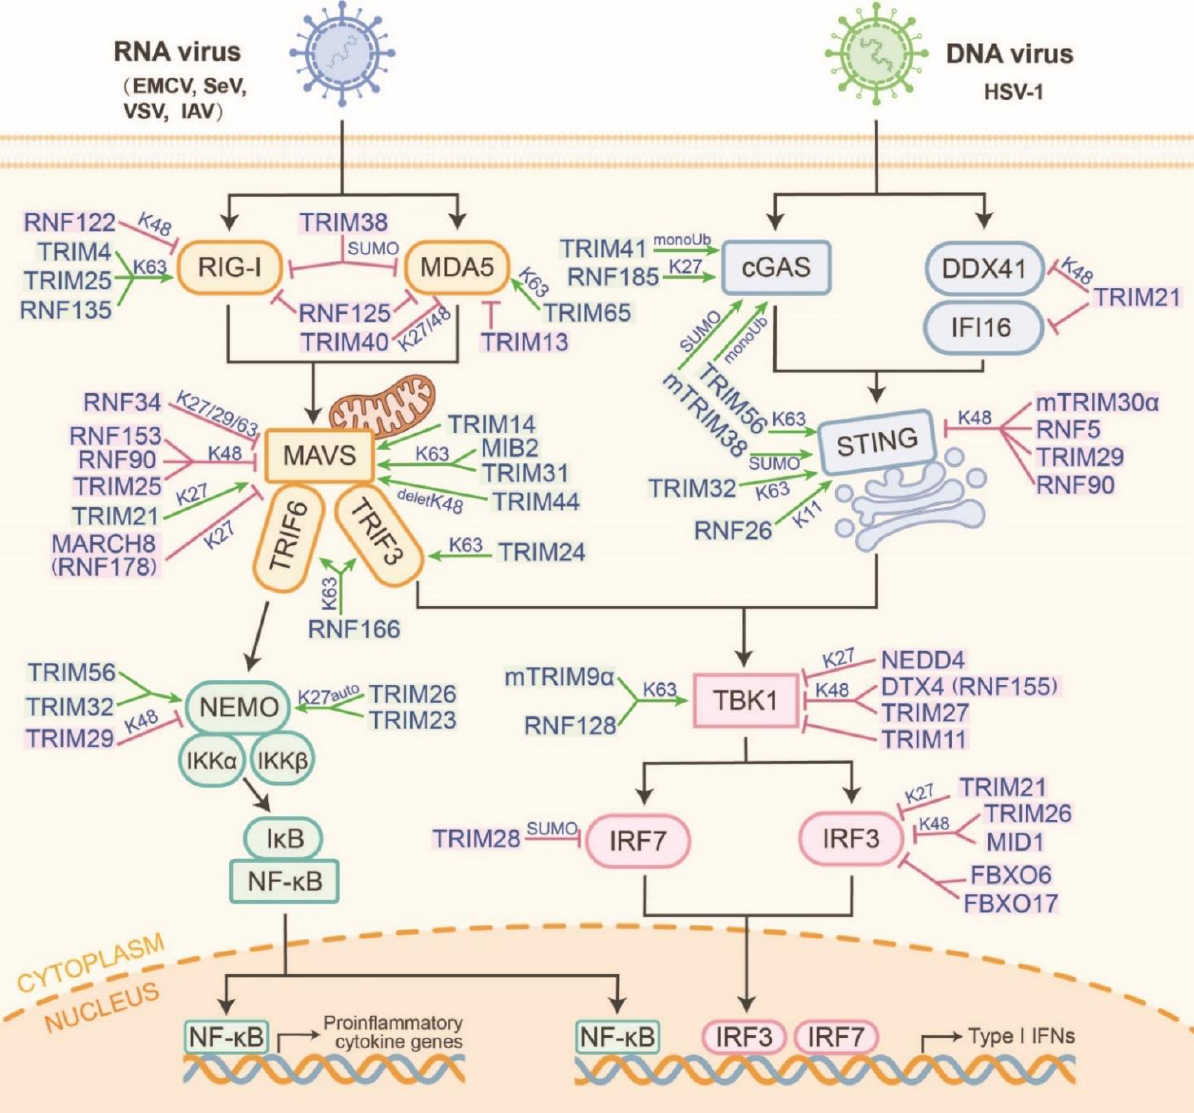
Figure 2. The comprehensive networks of RING-type E3s that regulate the RLR and cGAS-STING pathways. According to the mechanism of RING-type E3s regulatory function, four modes are classified as following: RING-type E3s directly target receptor proteins or act as intermediaries between signal transduction molecules and ubiquitin (e.g., TRIM25, RNF65, RNF185, etc.). RING-type E3s first perform auto-ubiquitylation and then interact with substrates via a signal transduction pathway (e.g., TRIM26). RING-type E3s mediate functional changes in substrates via ubiquitin-like modification (e.g., TRIM38-induced SUMOylation). RING-type E3s stabilize substrates by changing the ubiquitylation types or removing ubiquitylation (e.g., TRIM44 and RNF26). In the RLR pathway, RIG-I is autorepressed in physiological states and is activated after sensing virus infections. A model of the RIG-I activation process via E3-mediated sequential ubiquitylation has been proposed. The Riplet (also known as RNF135 or Reul) first ubiquitylates dsRNA-associated RIG-I at K788 to release the CARDs from autorepres- sion [8,9]. The released CARDs are catalyzed into K63-linked ubiquitin chains at various sites. TRIM25 synthesizes K63-linked ubiquitin chains to decorate the RIG-I CARD on K172 [10,11]. TRIM4 is another E3 that modifies K63-linked polyubiquitin at the K164/172 of RIG-I to promote its activation and antiviral responses [12]. MEX3C (RNF194) also col- ocalizes with RIG-I and leads to its K63-linked ubiquitylation at the K48, K99, and K169